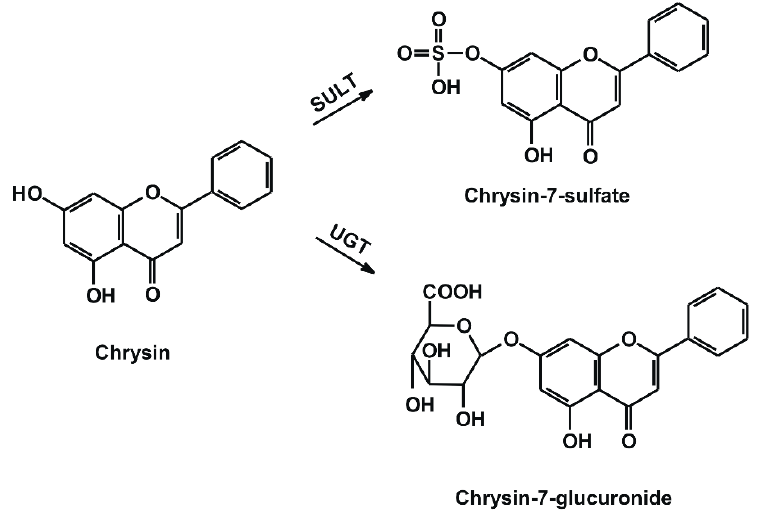
Figure 1. Chemical structures of chrysin, chrysin-7-sulfate, and chrysin-7-glucuronide (SULT: sulfotransferase; UGT: uridine 5 ′ -diphospho-glucuronosyltransferase).